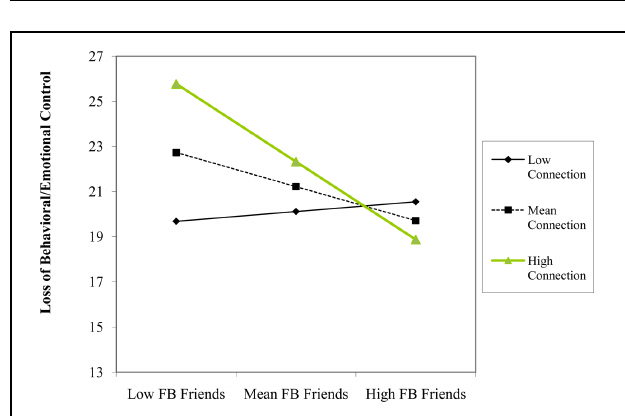
FIGURE 4 | Participant’s Facebook time and connection level as interactive predictors of scores on loss of behavioral/emotional control construct.